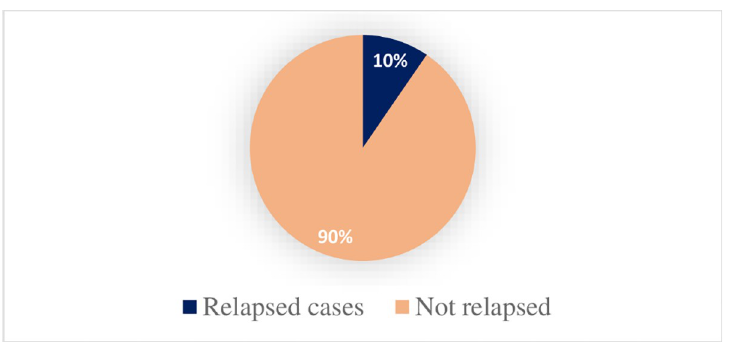
Fig 1. The number of relapsed cases of severe acute under nourished under five children in Hadiya Zone, SNNPR, Ethiopia from 2014/2015-2019/2020 (n = 900).